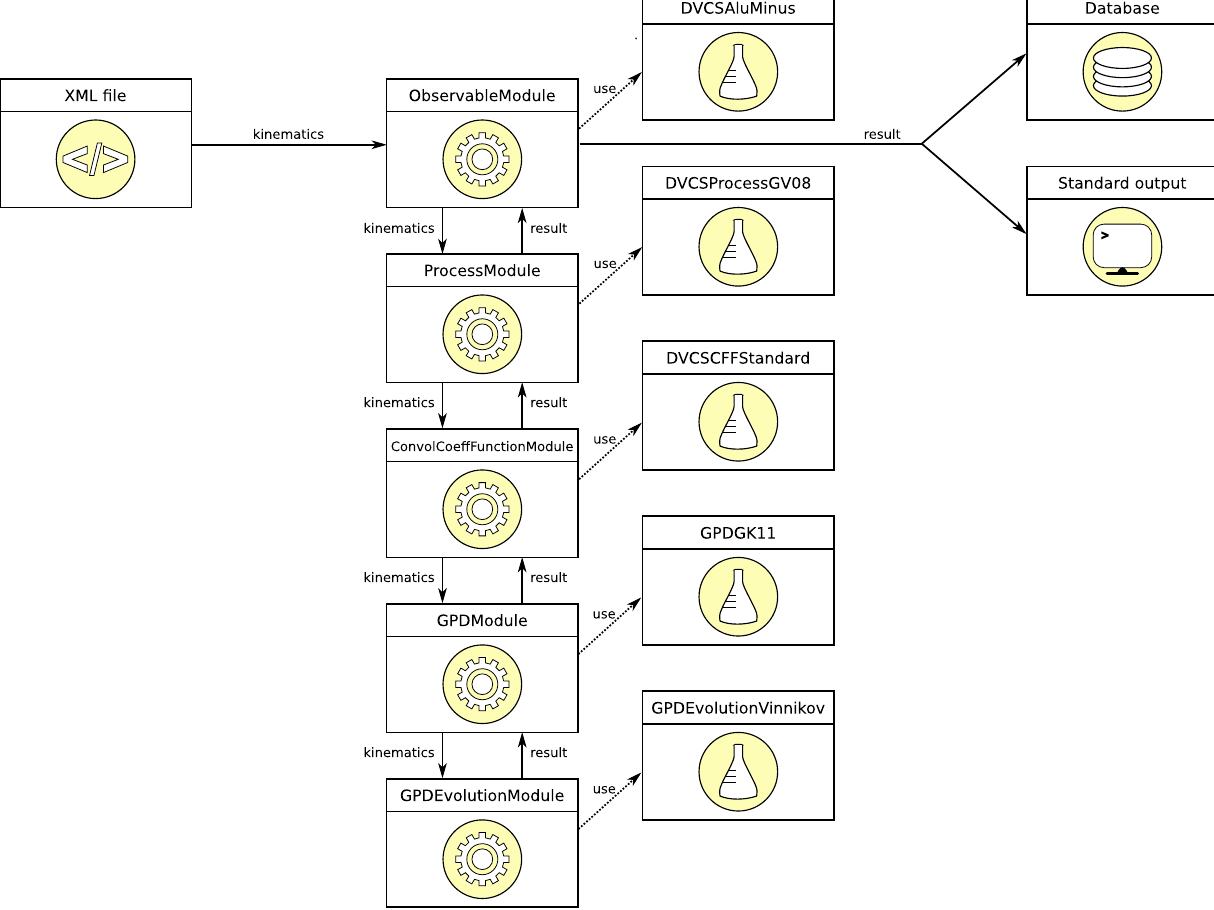
data selections, in which case kinematic cuts (for example a cut on − t / Q 2 to probe the Bjorken limit) are simple and